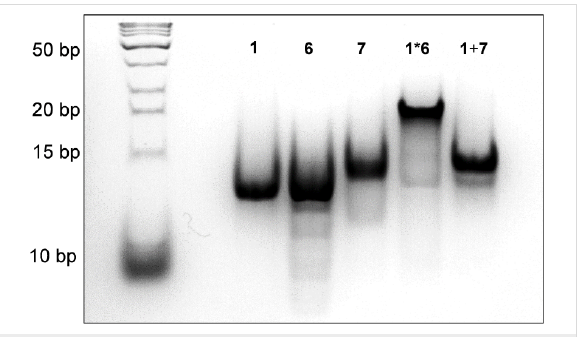
Figure 7: PAGE experiment. All oligomers were used in a total amount of 150 pmol in 10 mM sodium phosphate buffer, 100 mM NaCl